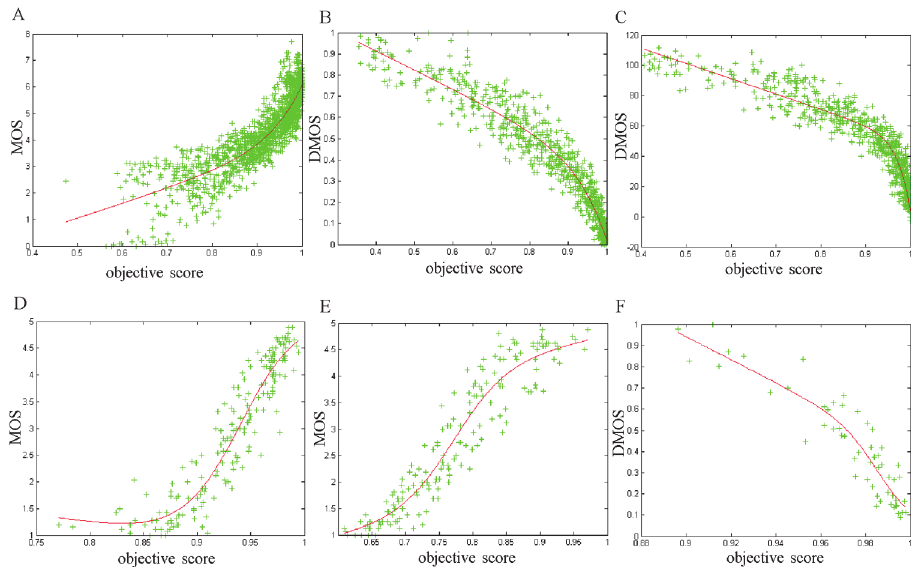
Fig 7. Scatter plots of our IQA scheme on six image databases. (A) TID 2008. (B) CSIQ. (C) LIVE. (D) IVC. (E) MICT. (F)